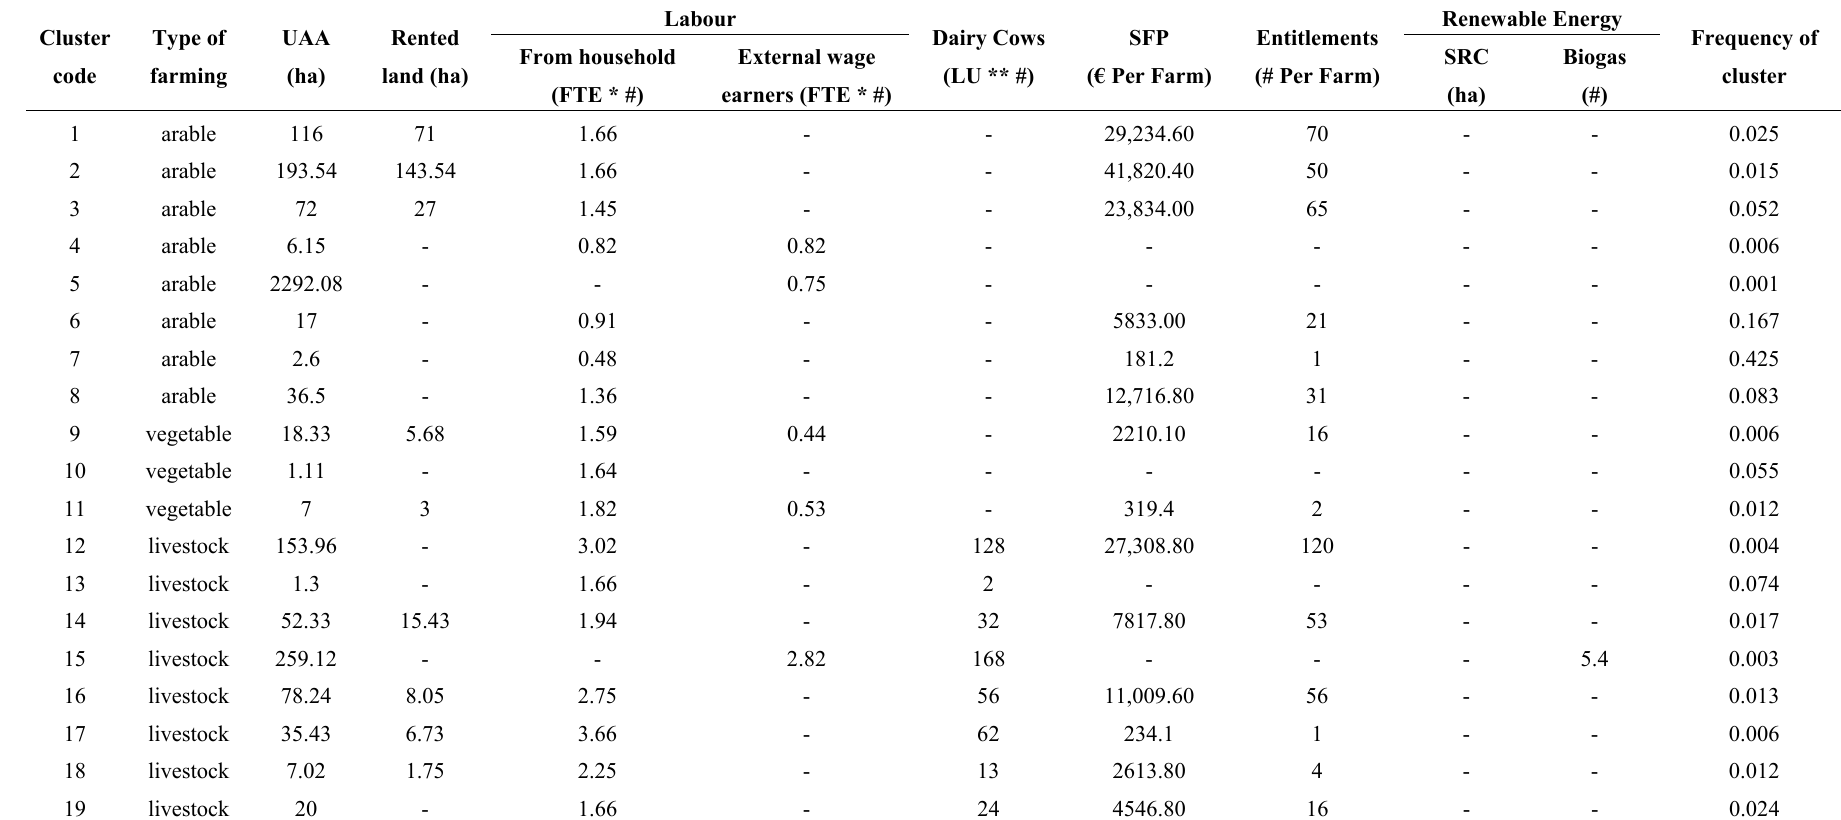
Table 2. Features and frequencies of the